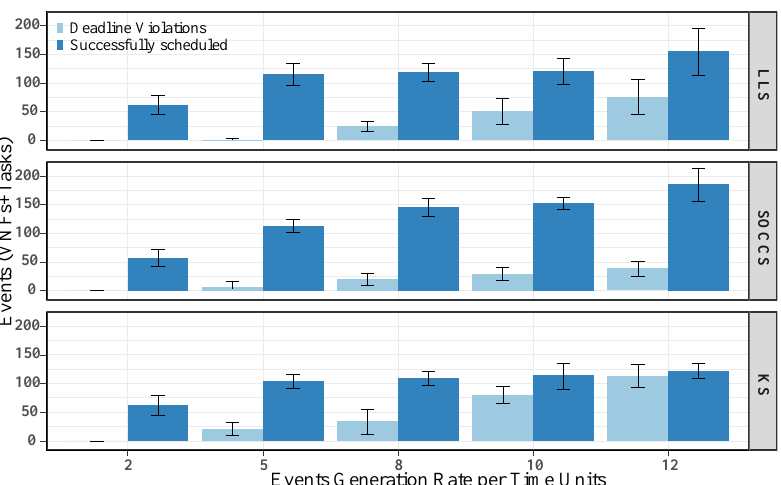
Figure 13. Number of successfully scheduled events and deadline violations for each scheduling